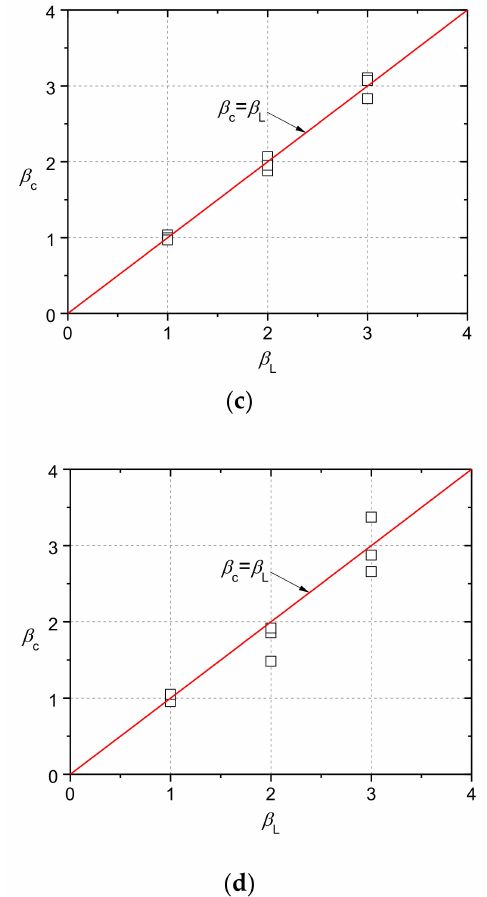
Figure 14. Results of bearing strength: ( a ) NC; ( b ) CRC5E; ( c ) CRC5; ( d )